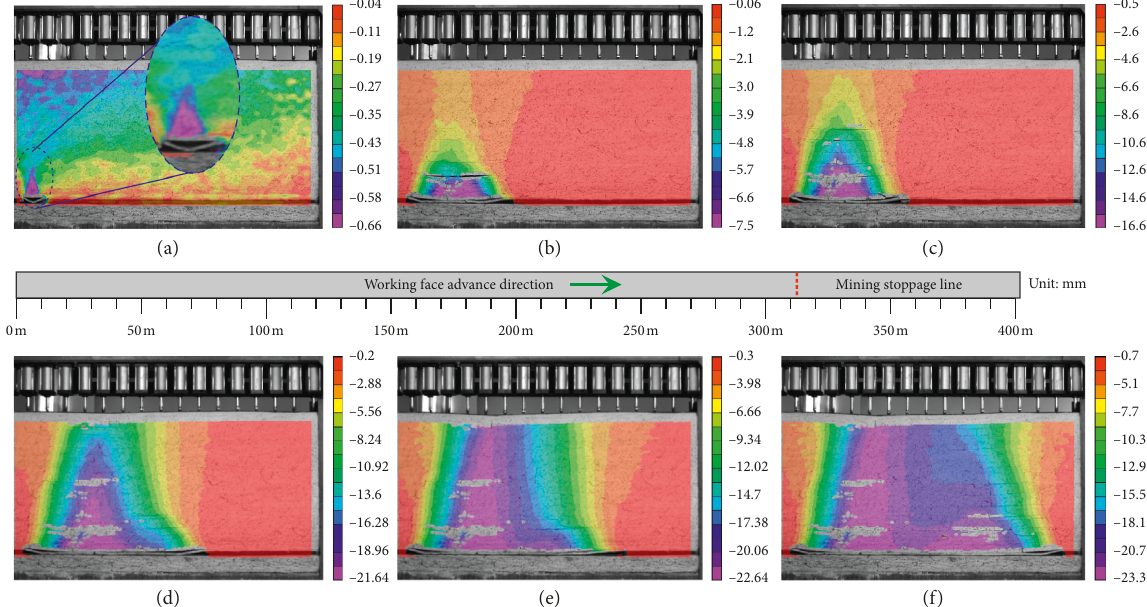
Figure 10: Contour plots for the characteristics of overburden movement: (a) 12.5m, (b) 55m, (c) 117m, (d) 210 m, (e) 242m, and (f)